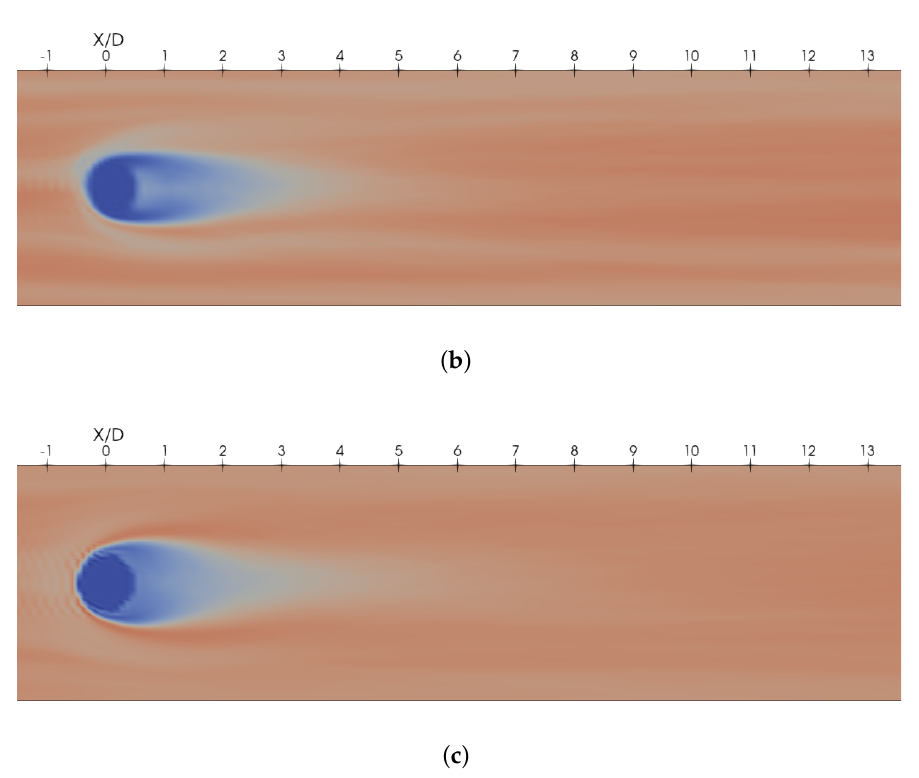
Figure 21. Topview of coolant concentration contours (passive scalar) at y + ≈ 0. ( a ) VR = 0.5 ZPG. ( b ) VR = 0.5 FPG. ( c ) VR = 1